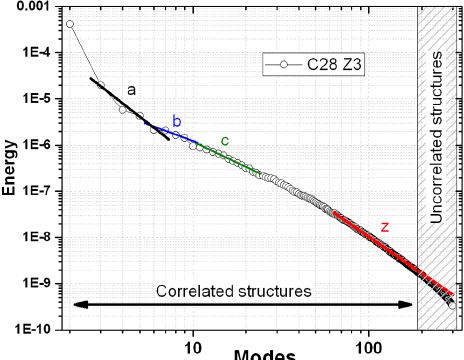
Figure 15. Energy distribution of the modes of the POD for variable Z 3 for ensemble member 28. Superimposed power laws indicate the “energy cascades” in correlated modes, and three principal scales are present: a, b, and c. The limit of the cascade is labeled z, and the shaded area indicates modes associated with